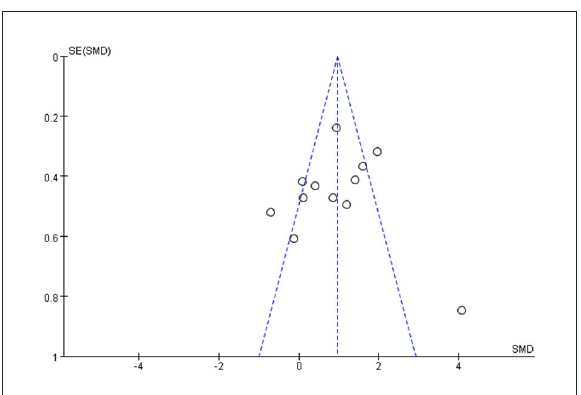
FIGURE9 Funnel chart of step length for